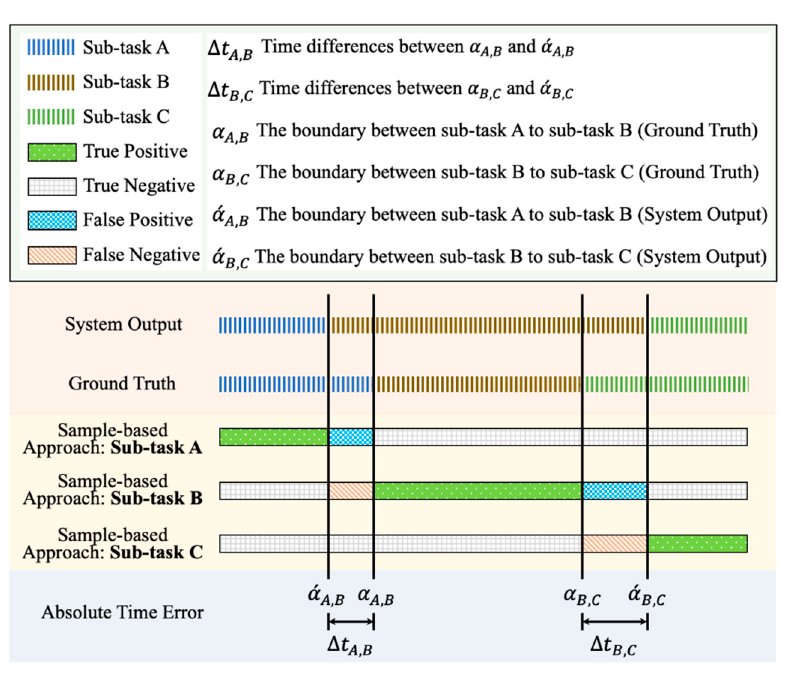
Figure 7. An illustration of the annotation for the performance evaluation of sub-task segmentation, including true positive, true negative, false positive, false negative, and absolute time error.